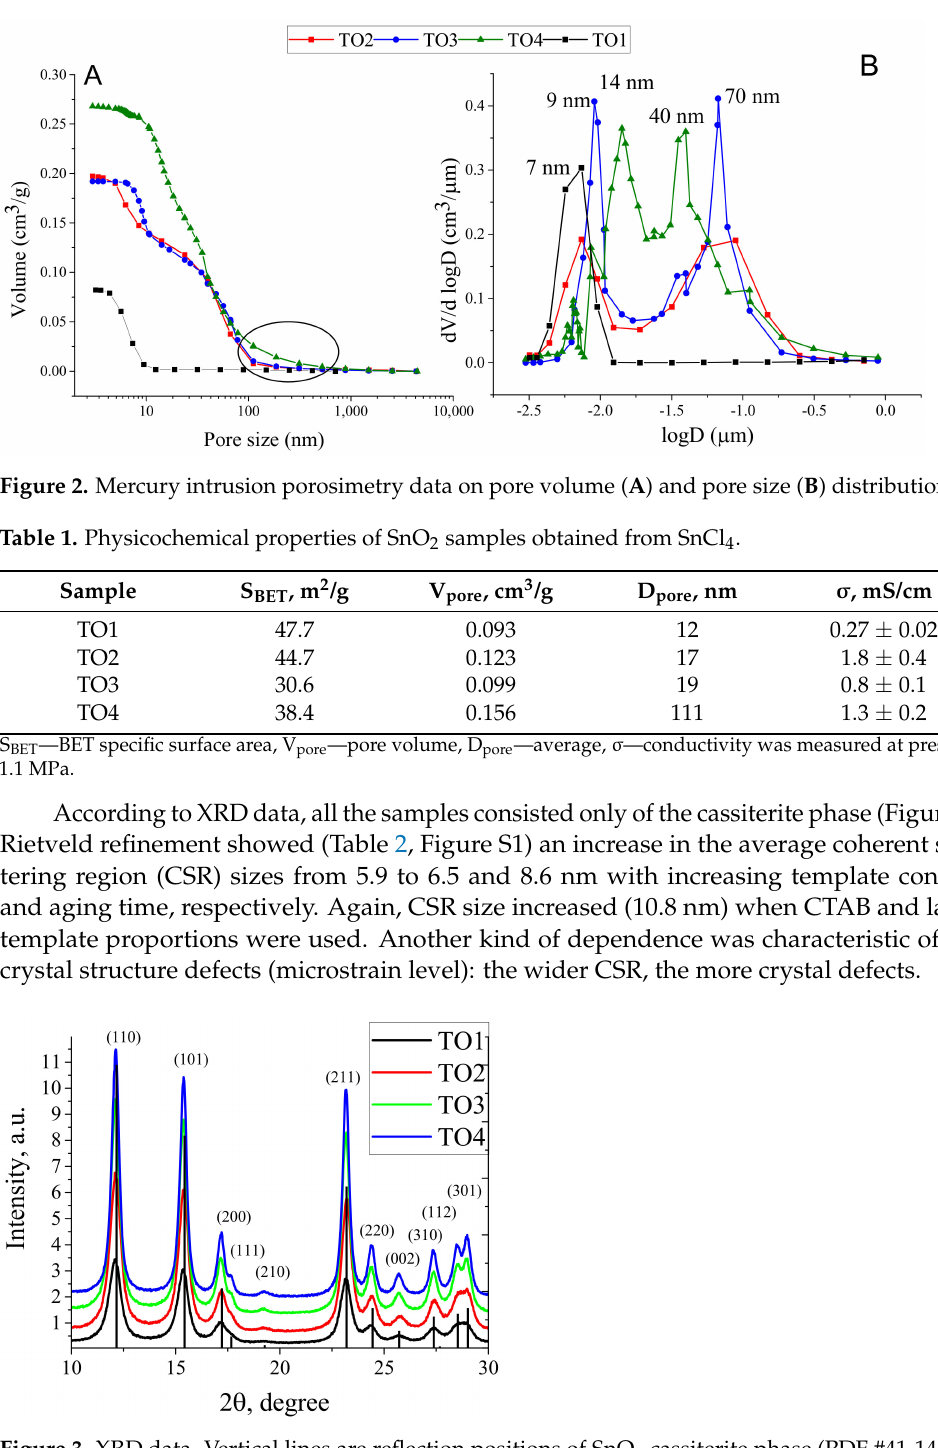
Figure 3. XRD data. Vertical lines are reflection positions of SnO 2 cassiterite phase (PDF #41-1445). XPS data show the presence of oxygen and tin on the surface (Figure 4). Sn3d binding energies of the samples were 486.9/495.4 eV for TO1, 487.1/495.6 eV for TO2, 487.0/495.5 eV for TO3, and 487.0/495.4 eV for TO4. Similar values were obtained for SnO 2 : 486.8 eV for Sn3d 5/2 and 495.4 eV for Sn3d 3/2 [28]. Peaks difference is 8.5 eV, which corresponds to